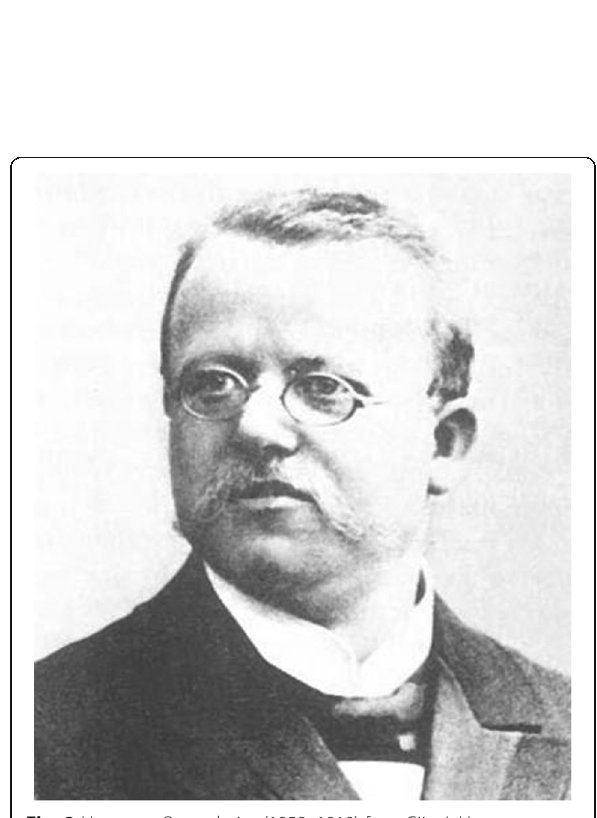
Fig. 2 Hermann Oppenheim (1858 – 1919) [van Gijn J. Hermann Oppenheim (1858 – 1919). J Neurol